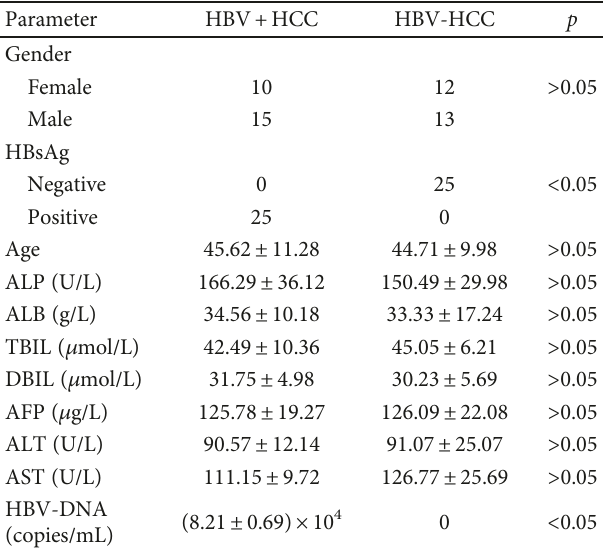
Table 2: Clinical features of